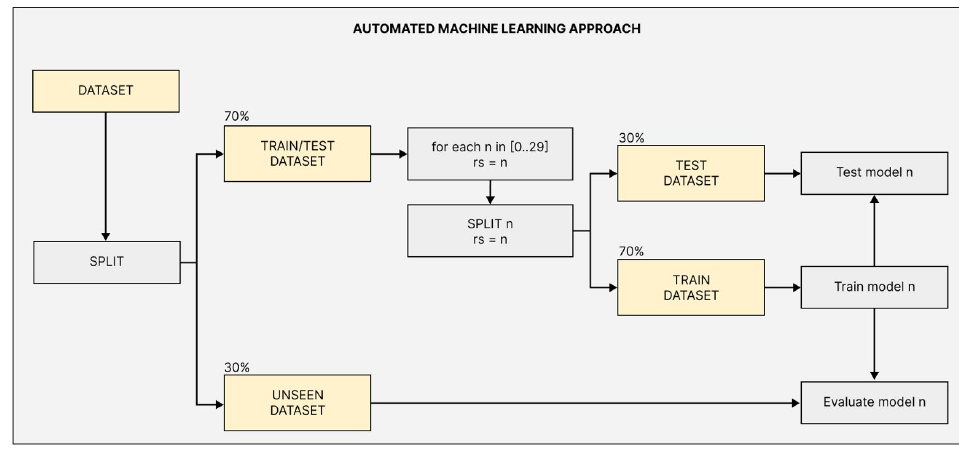
Figure 3. Flowchart of the classifier implementation and evaluation